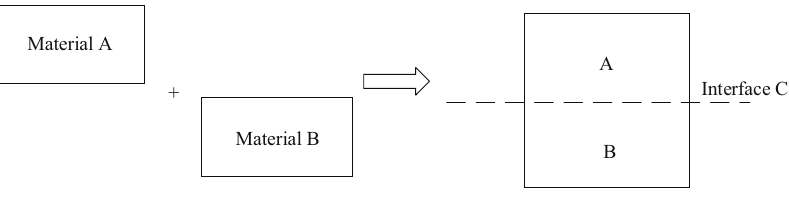
Figure 16: Diagram of interaction energy.